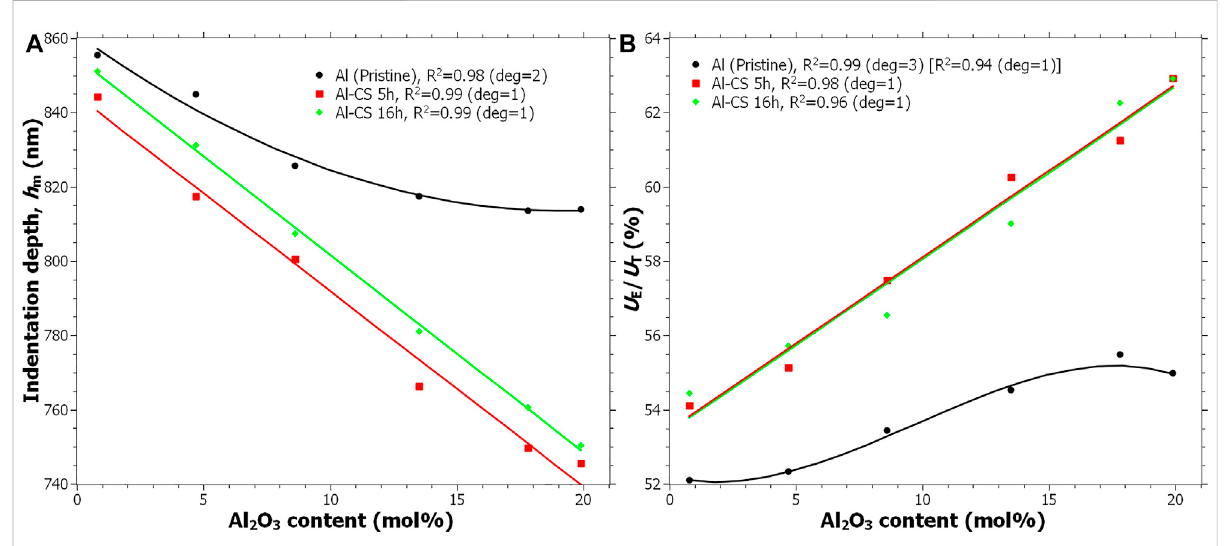
FIGURE 12 (A) Indentation depth and (B) U E /U T as a function of Al 2 O 3 content. The data originates from nanoindentations of 75 mN load; see Supplementary Table